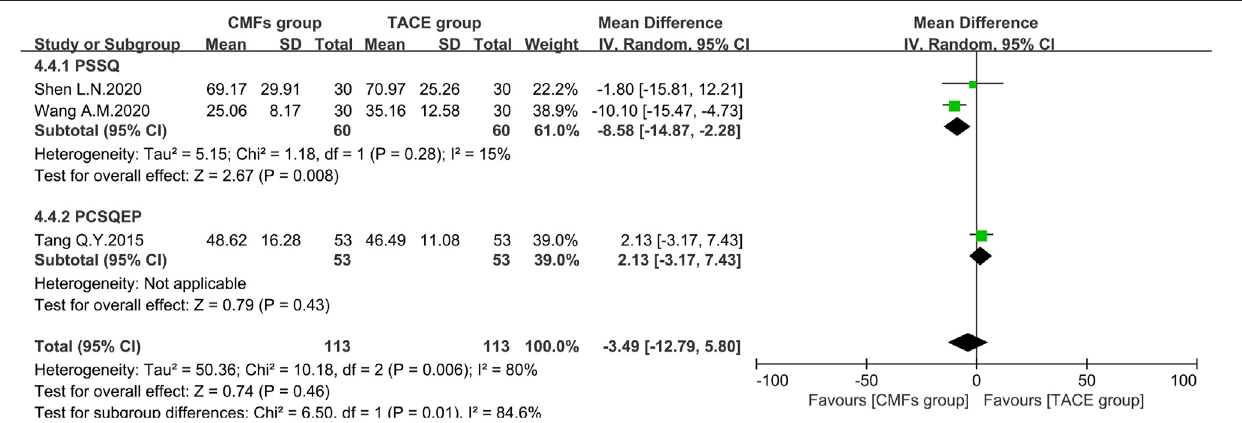
FIGURE 11 | Effect of CMFs group versus TACE group on AST after treated with TACE for 4 weeks, including a comparison between PSSQ and PCSQEP in the subgroup.